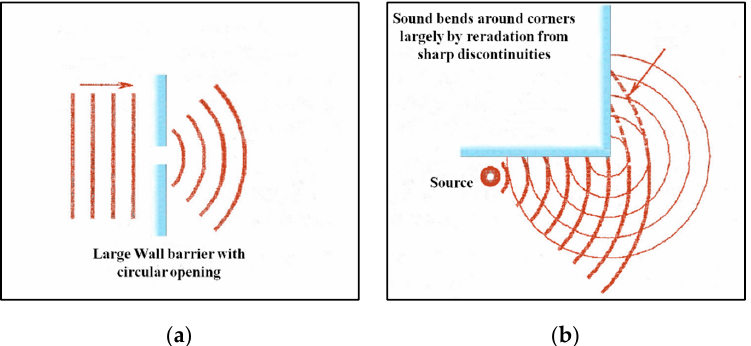
Figure 2. Di ff raction—sound physical phenomenon. ( a ) Behind obstacles or around the edges of an opening. ( b ) Around